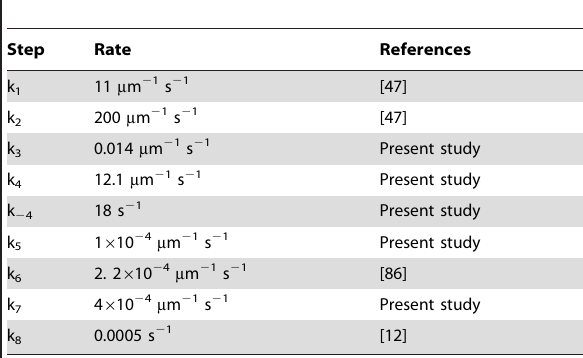
Table 1. Rates for the reactions depicted in the kinetic model in Fig. 9.